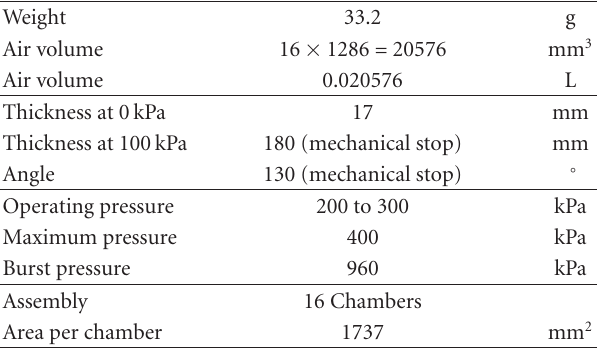
Table 2: Data sheet of the elbow